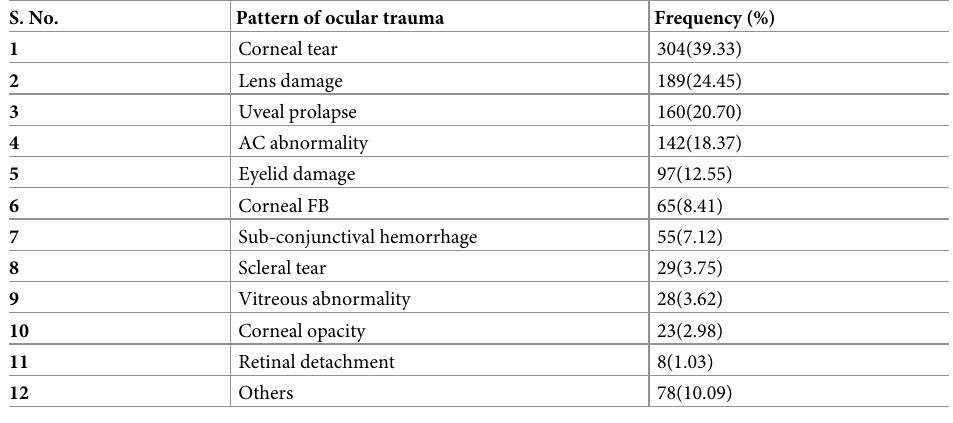
Table 3. Patterns of ocular trauma and their distribution among patients treated at Hawassa University, Referral Hospital, from January 01, 2012 to July 31, 2014 (N = 773). S.